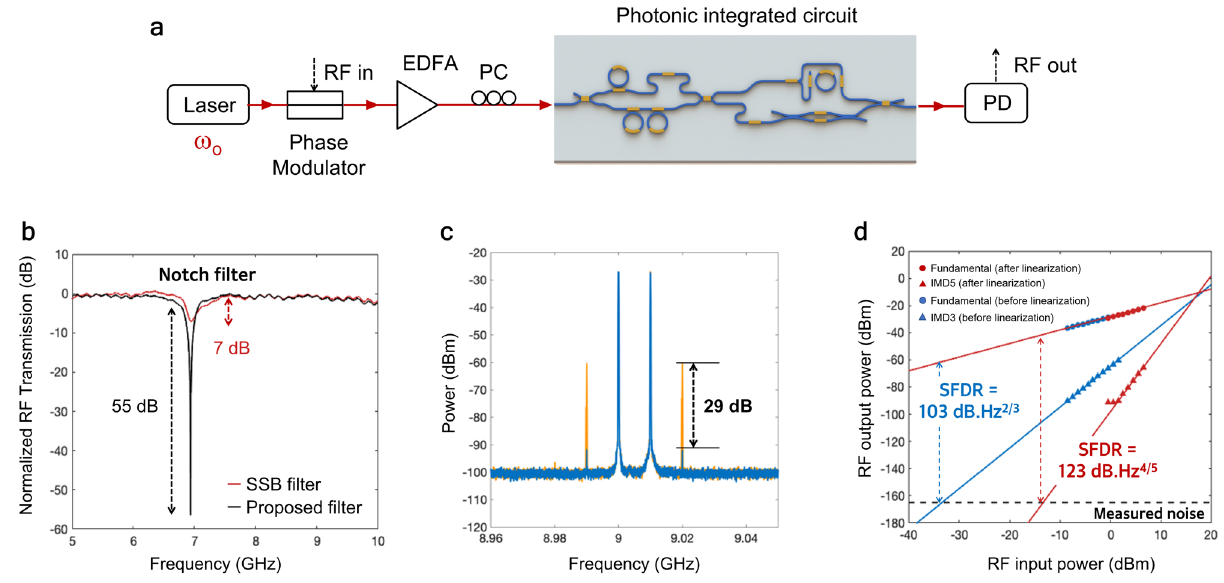
Fig. 4 | Linearization of RF notch fi lter. a Experiment setup of simultaneous RF notch fi lterwithlinearizationinaphasemodulator(PM)-basedsystem. b Measured RF notch fi lter with 55 dB rejection. c The measured two-tone RF spectra at the output of the photodetector for the linearized RF notch fi lter (blue) and single- sideband(SSB)RFnotch fi lterwithoutlinearization(yellow)with29dBreductionof IMD3powerwasachieved. d Themeasured spurious-free dynamicrange(SFDR)of